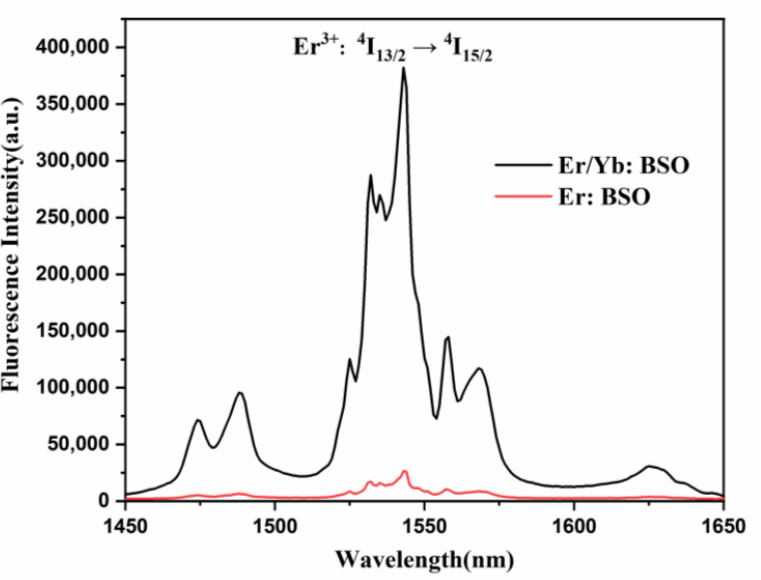
Figure 6. The emission spectra of the Er: BSO and Er/Yb: BSO crystals under 976 nm excitation.